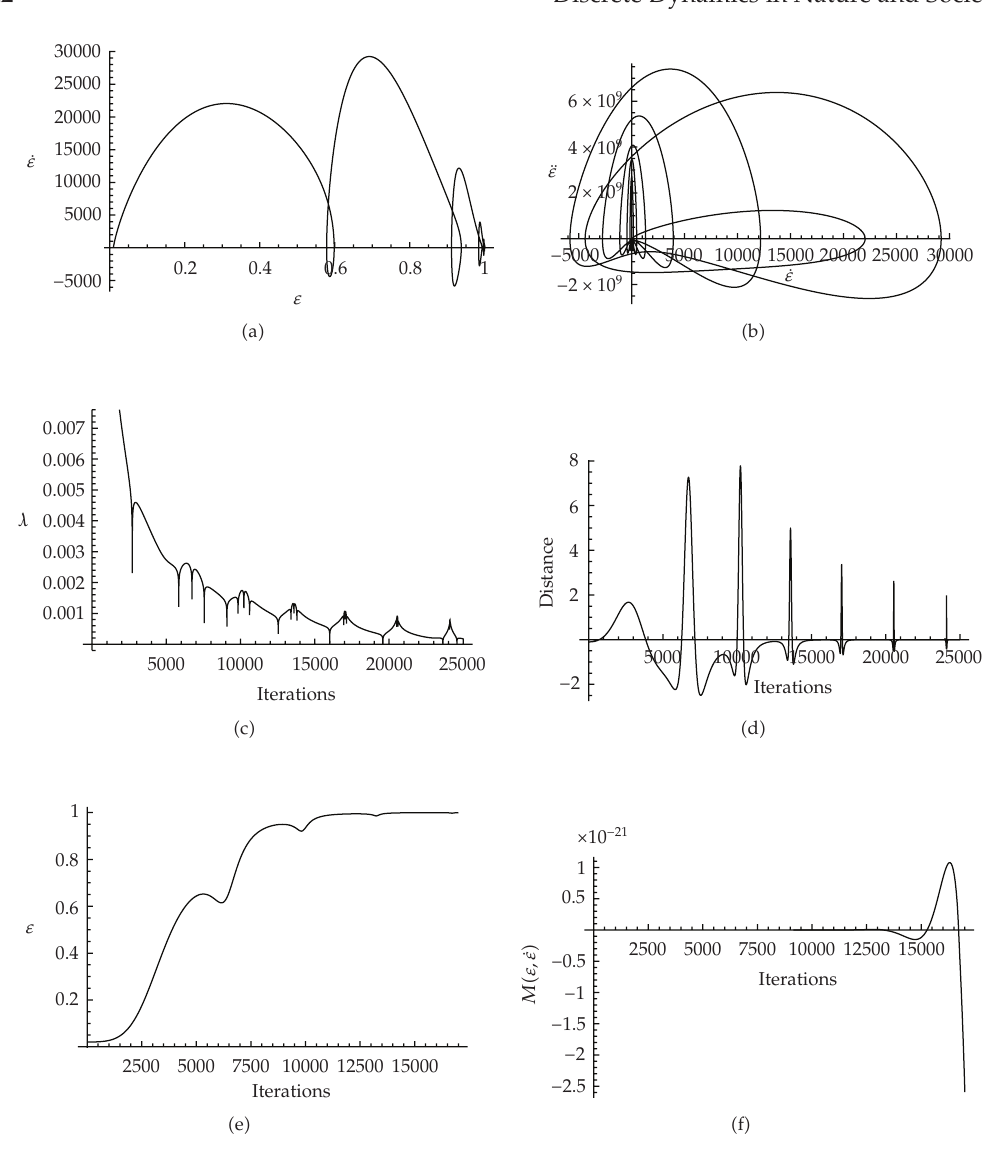
Figure 3: (cid:6) a (cid:7) and (cid:6) b (cid:7) The orbit of an attractor in two phase space graphs. Initial conditions: ε (cid:3) 0 . 01, ˙ ε (cid:3) 55, ¨ ε (cid:3) 10 6 , M/α (cid:3) 556 . 85 GeV 2 , and μ (cid:3) 10 − 5 GeV − 1 . (cid:6) c (cid:7) The Lyapunov exponent λ . (cid:6) d (cid:7) The correlation between two close orbits: the attractor and an orbit which starts close to it (cid:6) distance 0.00001 (cid:7) . One can clearly see the correlation between the orbits, which is not a chaotic pattern. (cid:6) e (cid:7) and (cid:6) f (cid:7) ε and the e ff ective mass as a function of the number of time iterations. As ε becomes close to unity the mass fluctuation amplitude grows